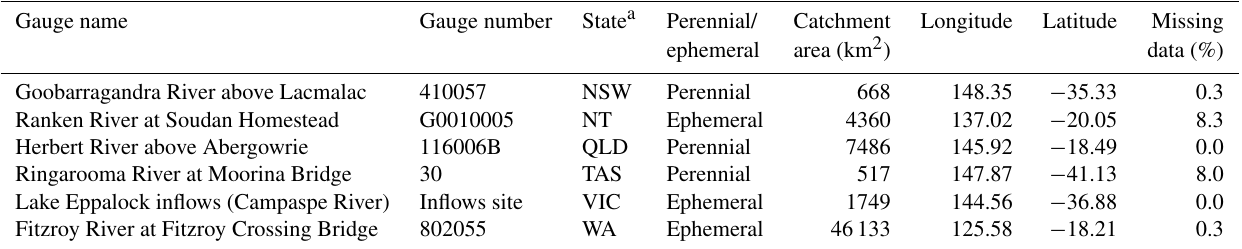
Table 1. Case study catchments.